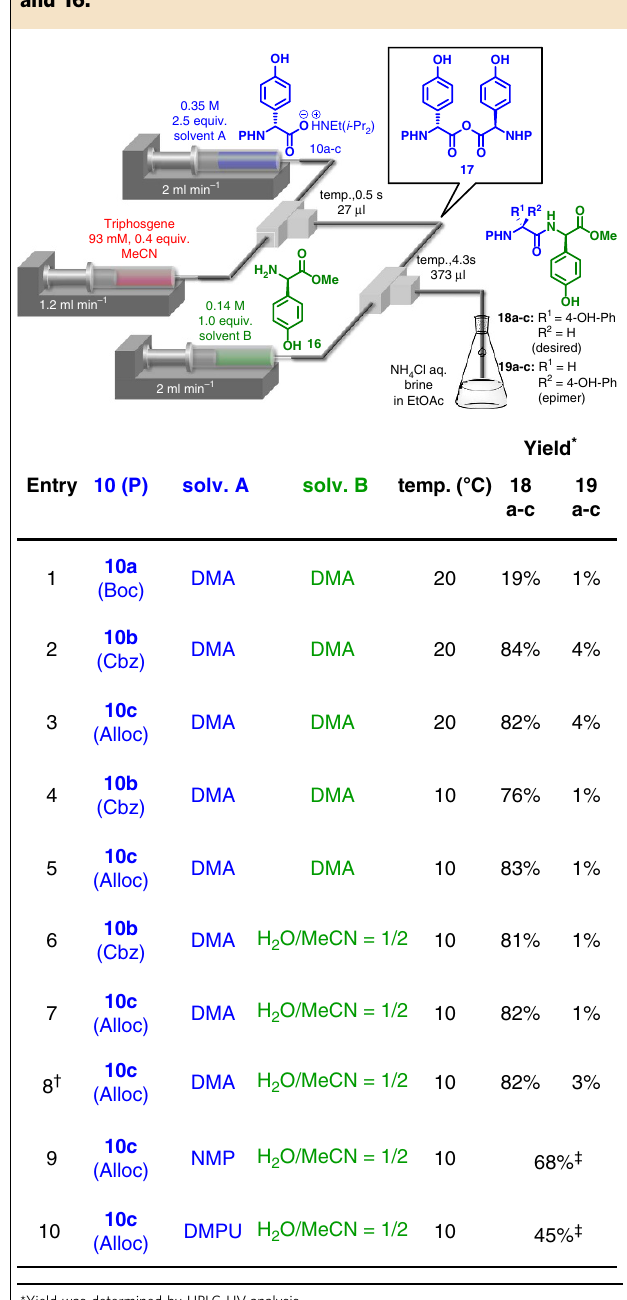
Table 1 | Micro-flow amide bond formation of D -Hpgs 10 and